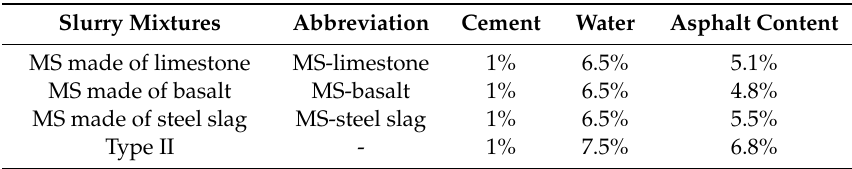
Table 3. Material rates of four kinds of MS samples.